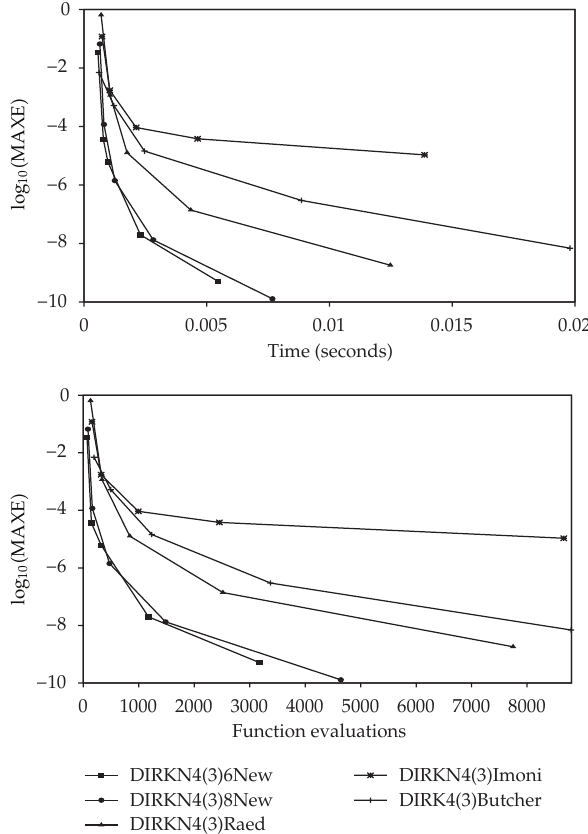
Figure 5: E ffi ciency curves for Problem